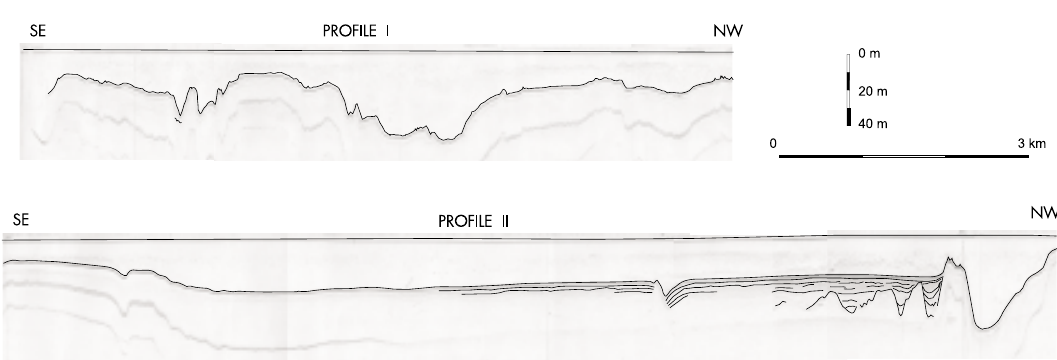
Fig. 8 – Seismic profiles 1 and 2, with internal reflectors and sea bed highlighted for clarity.